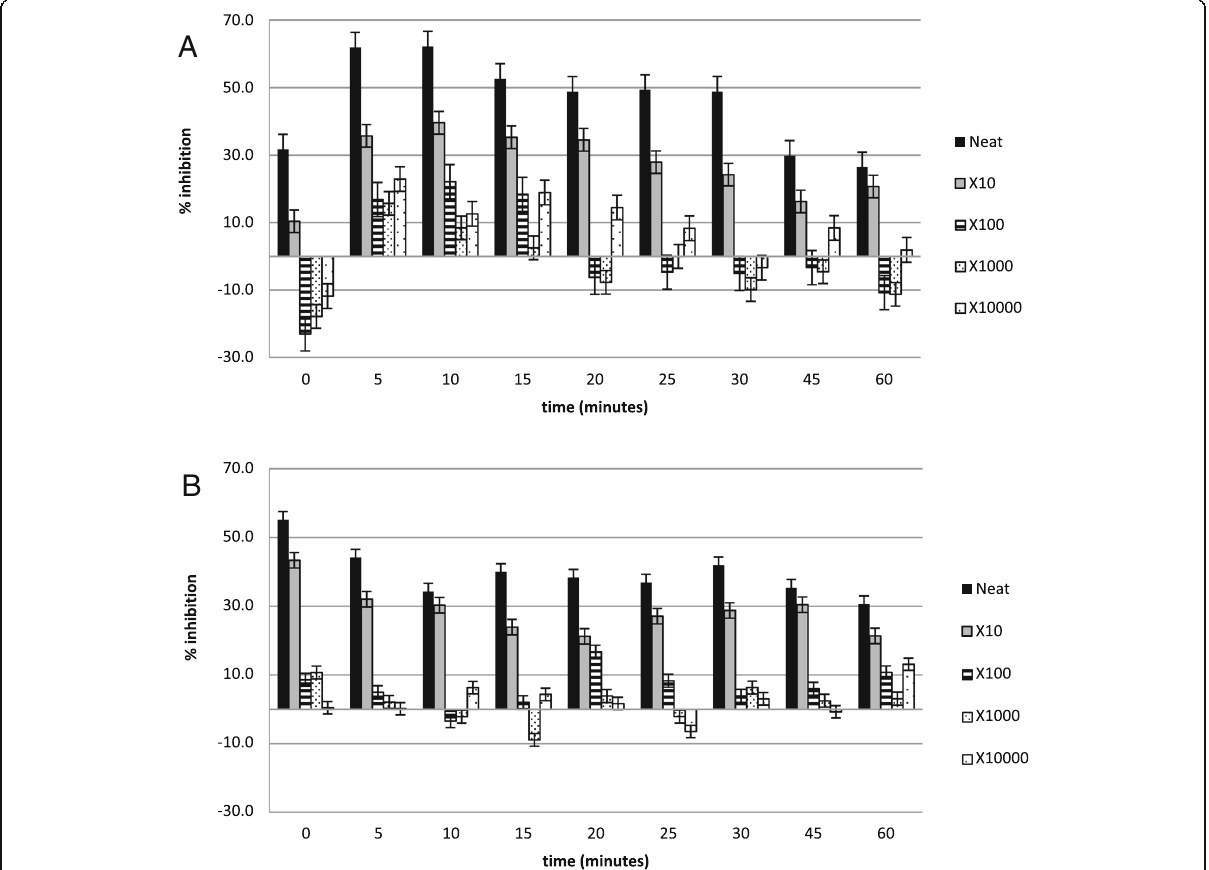
Fig. 6 The % inhibition of healthy platelets after incubation with the HM5 and diluted standards, and activation with ( a ) fMLP and ( b )